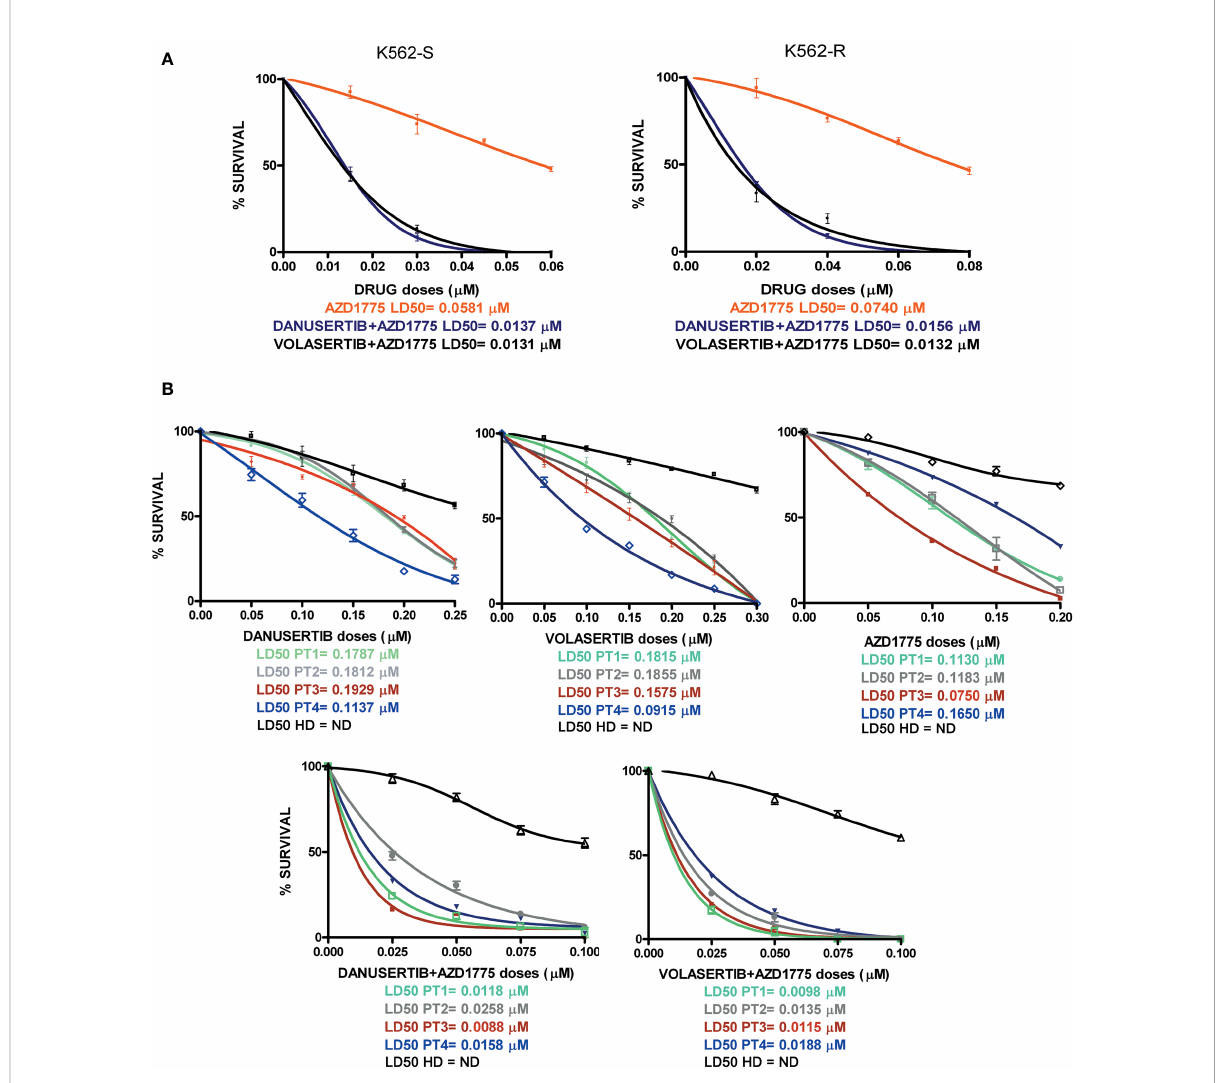
FIGURE 6 Effects of Aurora kinase A, PLK1 and WEE1 inhibition in K562S and K562R cell lines and in CD34+ cells derived from 4 BC CML patients and a pool of 8 healthy donors (HDs). Dose-dependent inhibition of survival was assessed in 14-day methylcellulose colony-forming assays. (A) K562S and -R cells and (B) CD34+ cells were treated with increasing concentrations of danusertib (Aurora kinase A inhibitor), volasertib (PLK1 inhibitor), AZD1775 (WEE1 inhibitor) danusertib+AZD1775, volasertib+AZD1775. The green line corresponds to patient 1, the gray line corresponds to patient 2, the red line corresponds to patient 3, the blue line corresponds to patient 4 and the black line corresponds to the pool of 8 healthy